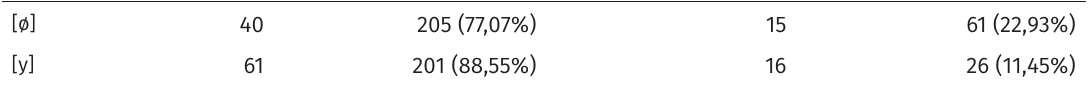
Table 2: Front rounded vowels (FRV) in stressed and unstressed